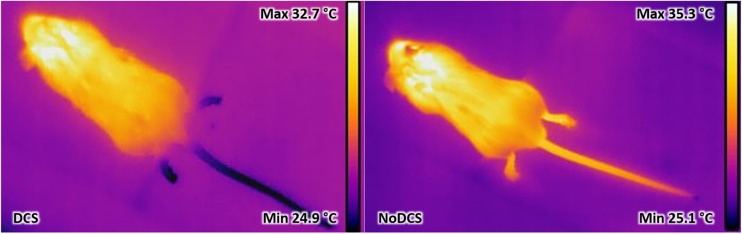
Example of infrared thermograms taken on mice C57Bl6 after leaving the hyperbaric chamber. The dark areas represent the coldest superficial areas and the light areas the hottest areas. In this example, the mouse on the left was considered during the clinical test to be suffering from decompression sickness. Dark areas were detected in the tail and its hind paws. The hottest area was generally not far from the ears. The mouse on the right was free from clinical signs indicating DCS. However, small cold area at the tip of the tail consecutive to the first blood sample taken before hyperbaric exposure was noted. It was also observed that in the tail the pilomotor reflex differs from the right-hand image: the swelling just before the beginning of the tail is larger on the right-hand image.